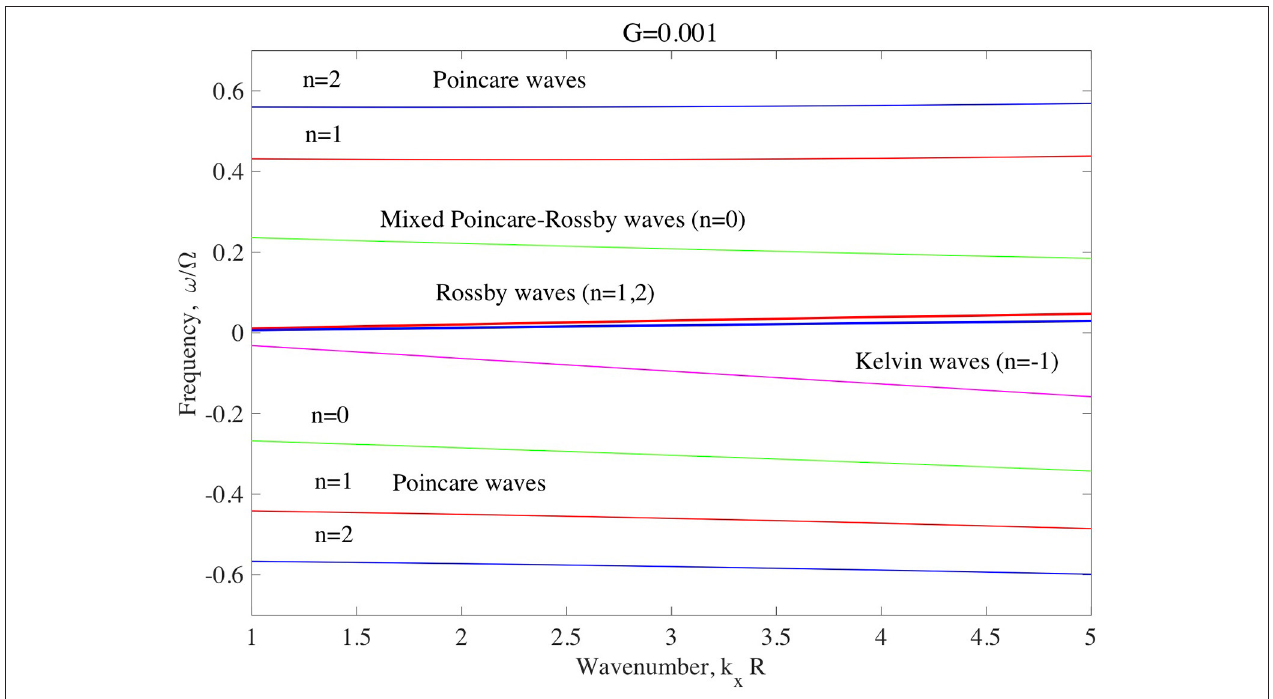
FIGURE 5 | Dispersion curves for various equatorial HD shallow water waves in the solar tachocline. Red and blue thin solid lines correspond to eastward (positive) and westward (negative) propagating Poincare waves. Red and Blue thick solid lines correspond to eastward propagating Rossby waves. Green solid lines correspond to eastward propagating n 0 mixed Poincare-Rossby waves and westward propagating n 0 Poincare waves. Magenta solid line corresponds to = = Kelvin waves. Here the normalized value of the reduced gravity is G 0.001. =